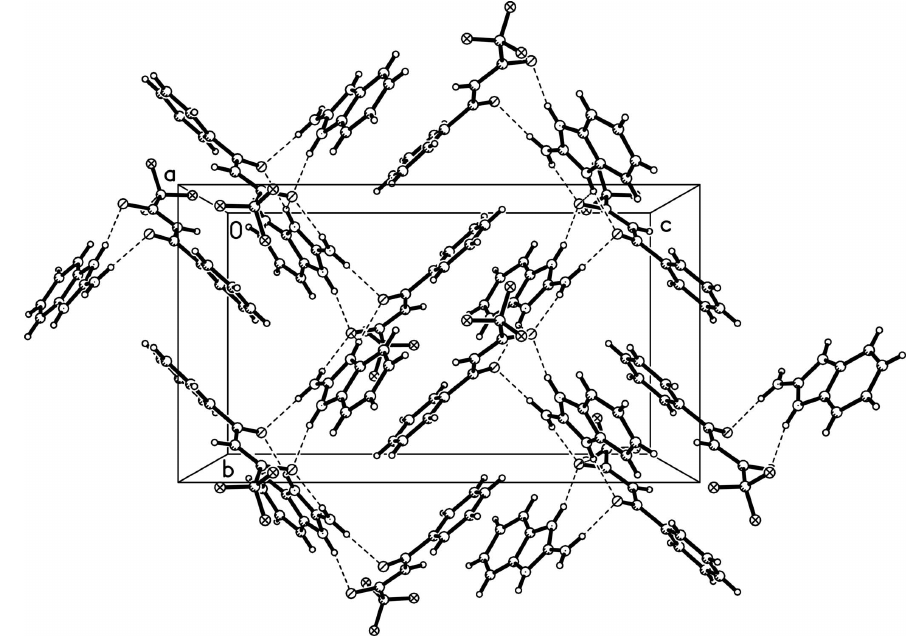
Figure 2 The packing diagram of the title compound. Intermolecular hydrogen bonds are shown as dashed